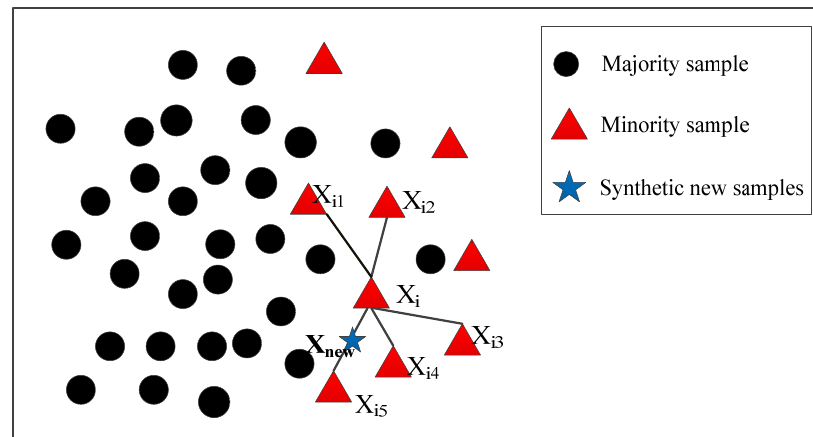
Figure 2. The SMOTE algorithm principle based on k proximity.